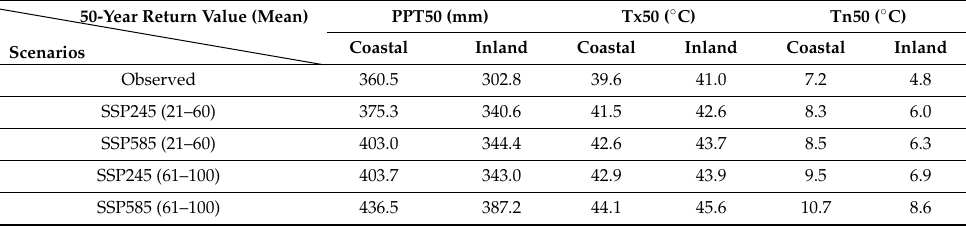
Table 1. Coastal and inland average estimate of climate extremes at present and under climate change with different scenarios in two future time